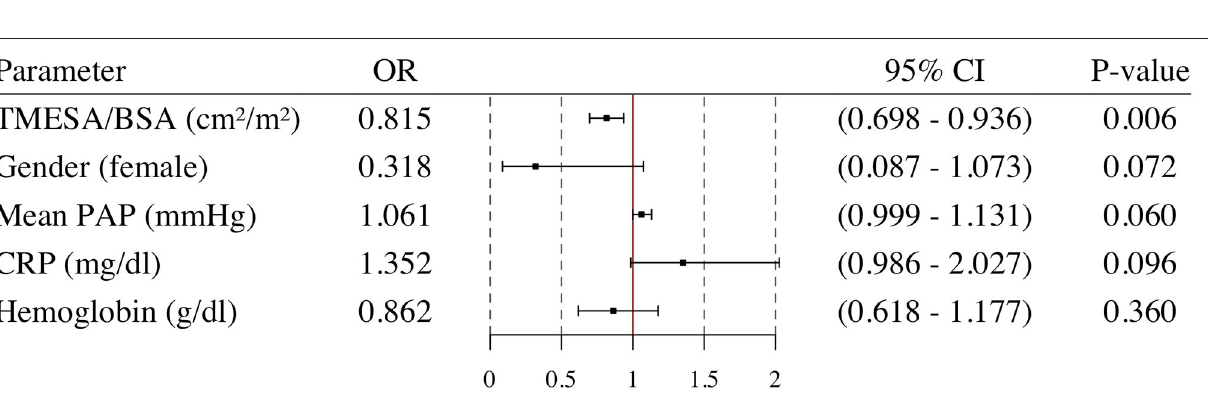
Frontiers in Cardiovascular Medicine |